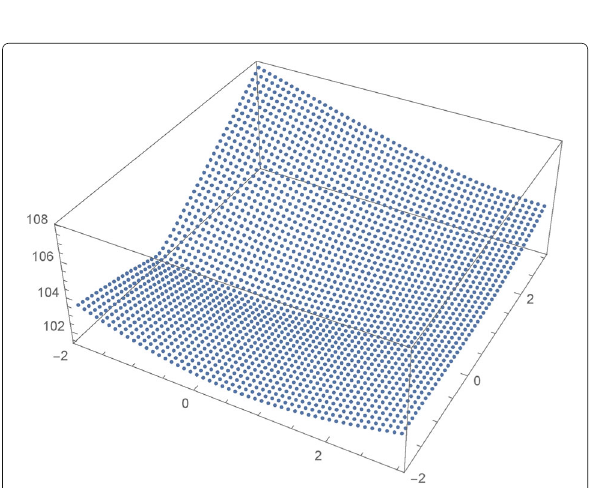
Fig. 12 Variance of the procurement cost V [ C